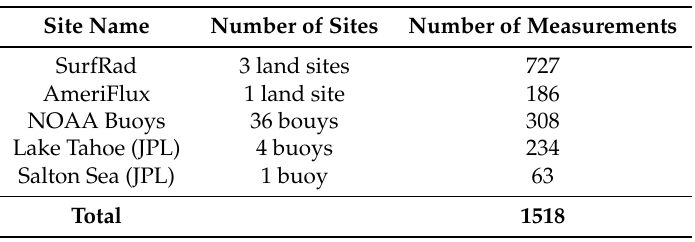
Table 2. A list of the reference data sources along with the number of measurements utilized for this